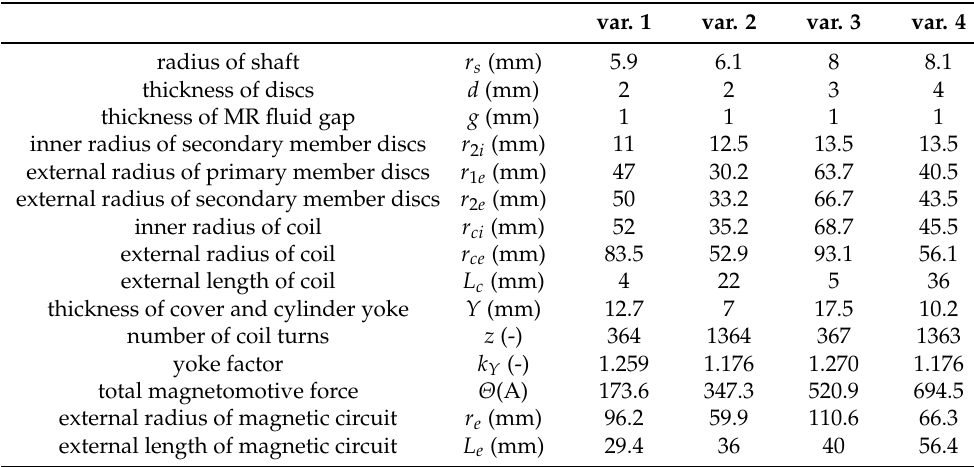
Table 1. The results of the design calculations for the selected variants.